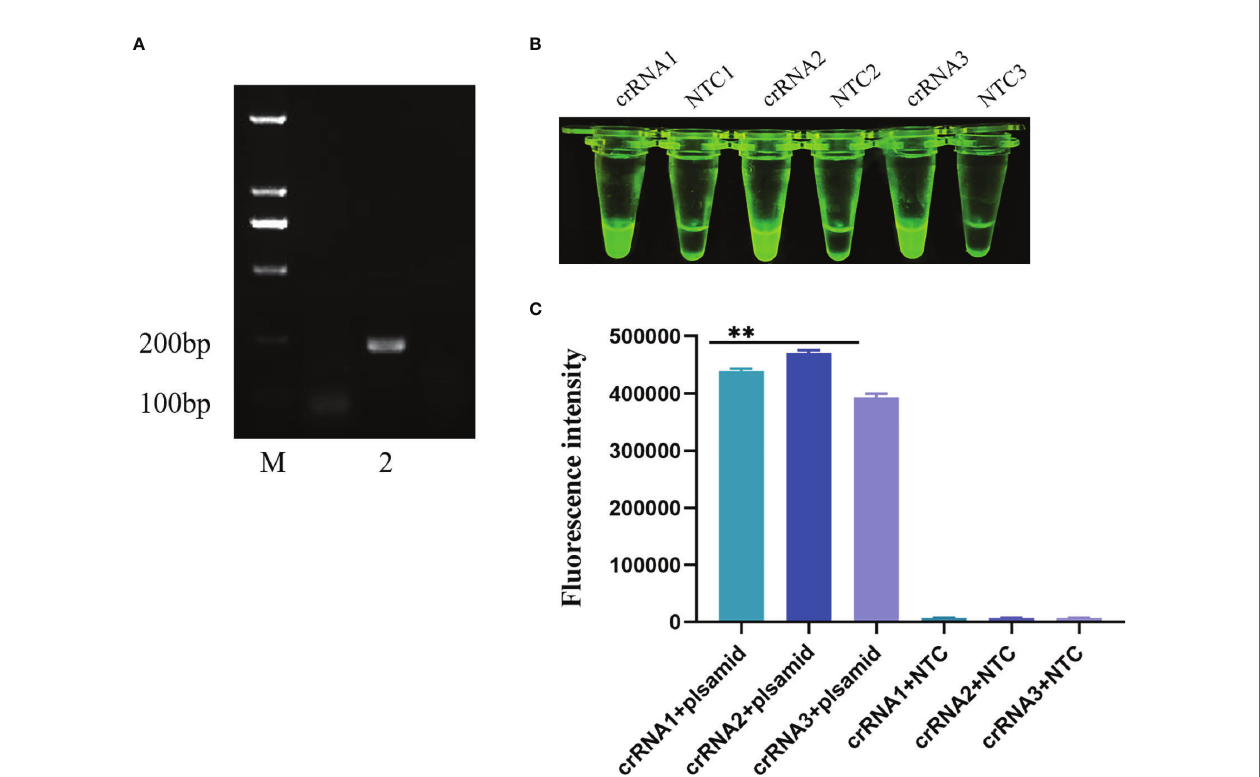
FIGURE 5 | Screening of crRNA primers. (A) ERA primer was applied to agarose gel electrophoresis after nucleic acid ampli fi cation. M: Marker; 2: The second upstream primer and the second downstream primer constitute the ERA primers for nucleic acid ampli fi cation results. (B, C) Three pairs of crRNA primers visualized for CRISPR/Cas12a. Comparison of results and fl uorescence values under UV light. All data are presented as the statistical signi fi cance of differences were **p <